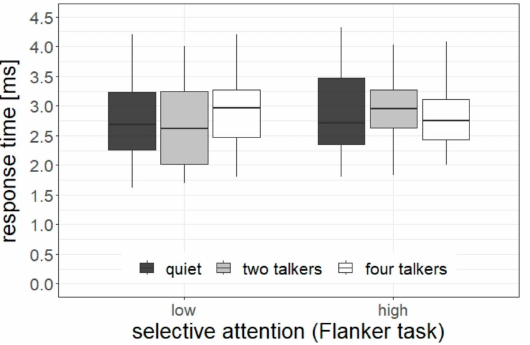
Figure 4. Response time (correct responses only) as a function of students’ selective attention (as assessed by the Flanker task) and listening condition.